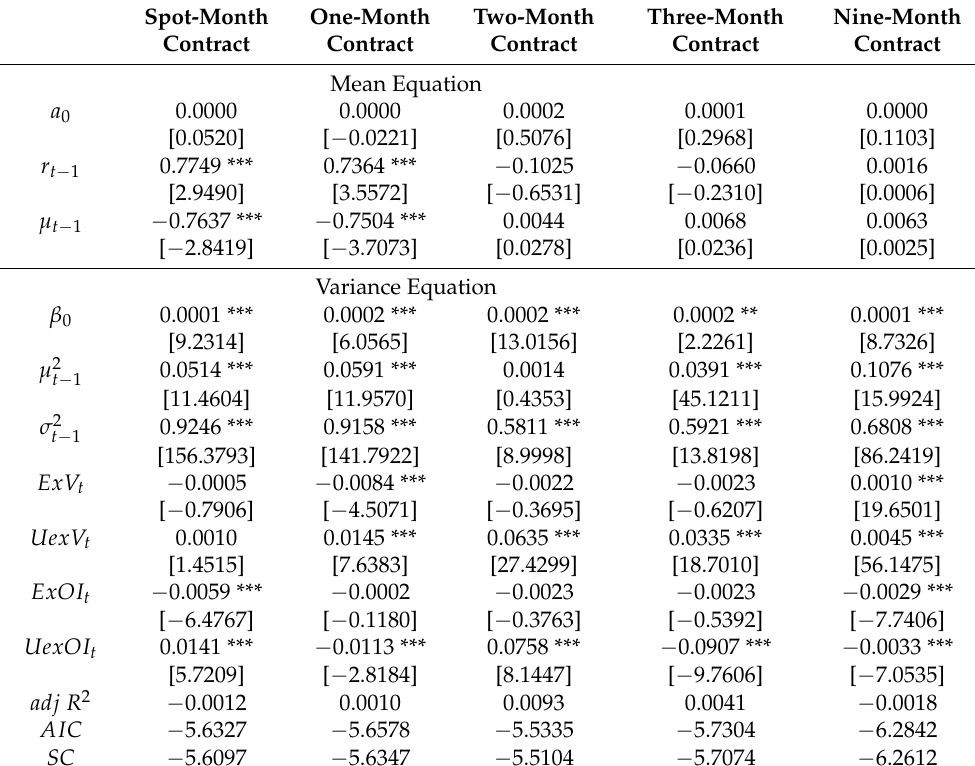
Table 4. Estimation Results of GARCH (1,1) for Malaysian Crude Palm Oil